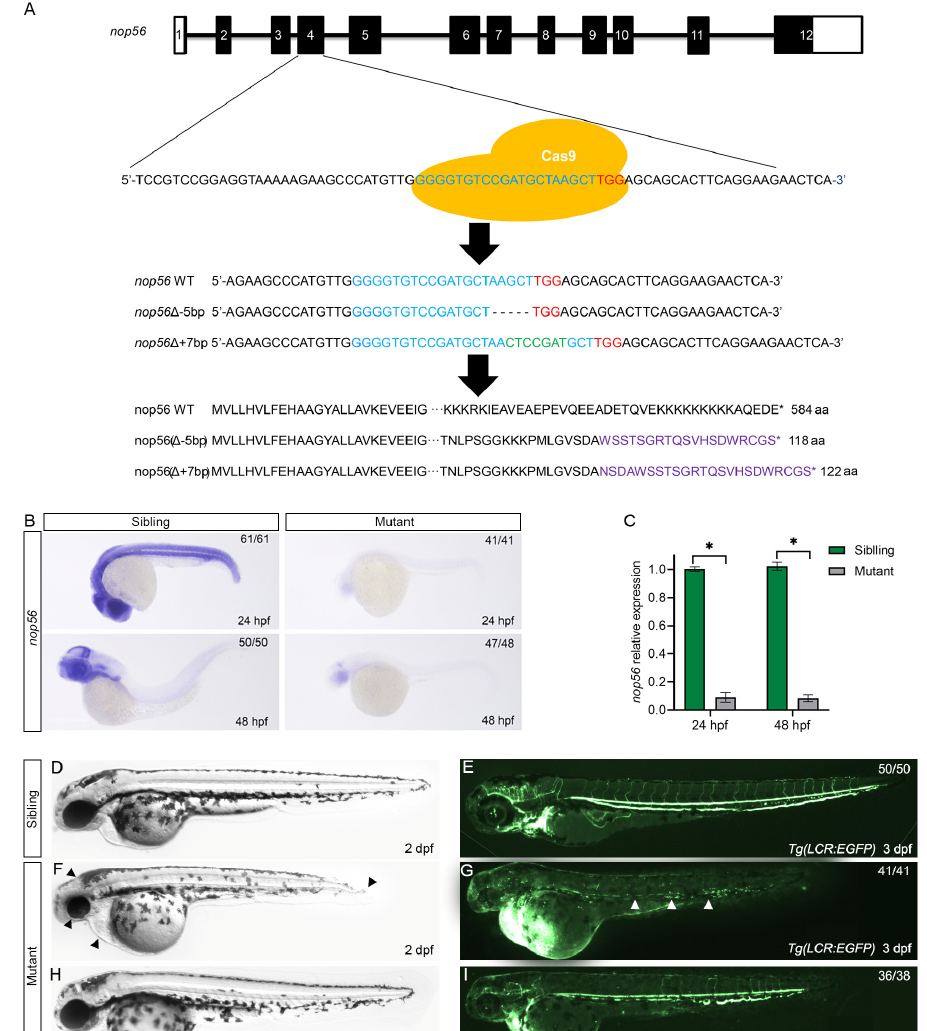
Figure 1. Generation of a nop56 mutation using the CRISPR/Cas9 system. ( A ) Schematic describing the target site of nop56 . The genomic sequences and predicted protein sequences based on the DNA sequence in the wildtype and nop56 − / − mutants are shown. ( B ) WISH of nop56 in the siblings and mutants at 24 and 48 hpf. The results were verified independently three times. ( C ) The qRT-PCR of nop56 transcript levels in the wildtype siblings and nop56 − / − mutants at 24 and 48 hpf. The qRT-PCR was performed with biological repeats and technical repeats in triplicate ( n = 3, * p <0.05). ( D – H ) In vitro-transcribed nop56 mRNA (400 pg) partially rescued the phenotype in nop56 mutants. A smaller head, edema in the heart, and a shorted tail extension (arrowhead) were present. ( E – I ) Analysis of blood cells in the Tg(LCR:EGFP) transgenic line. The arrowhead indicates red blood cells. All scale bars represent 1